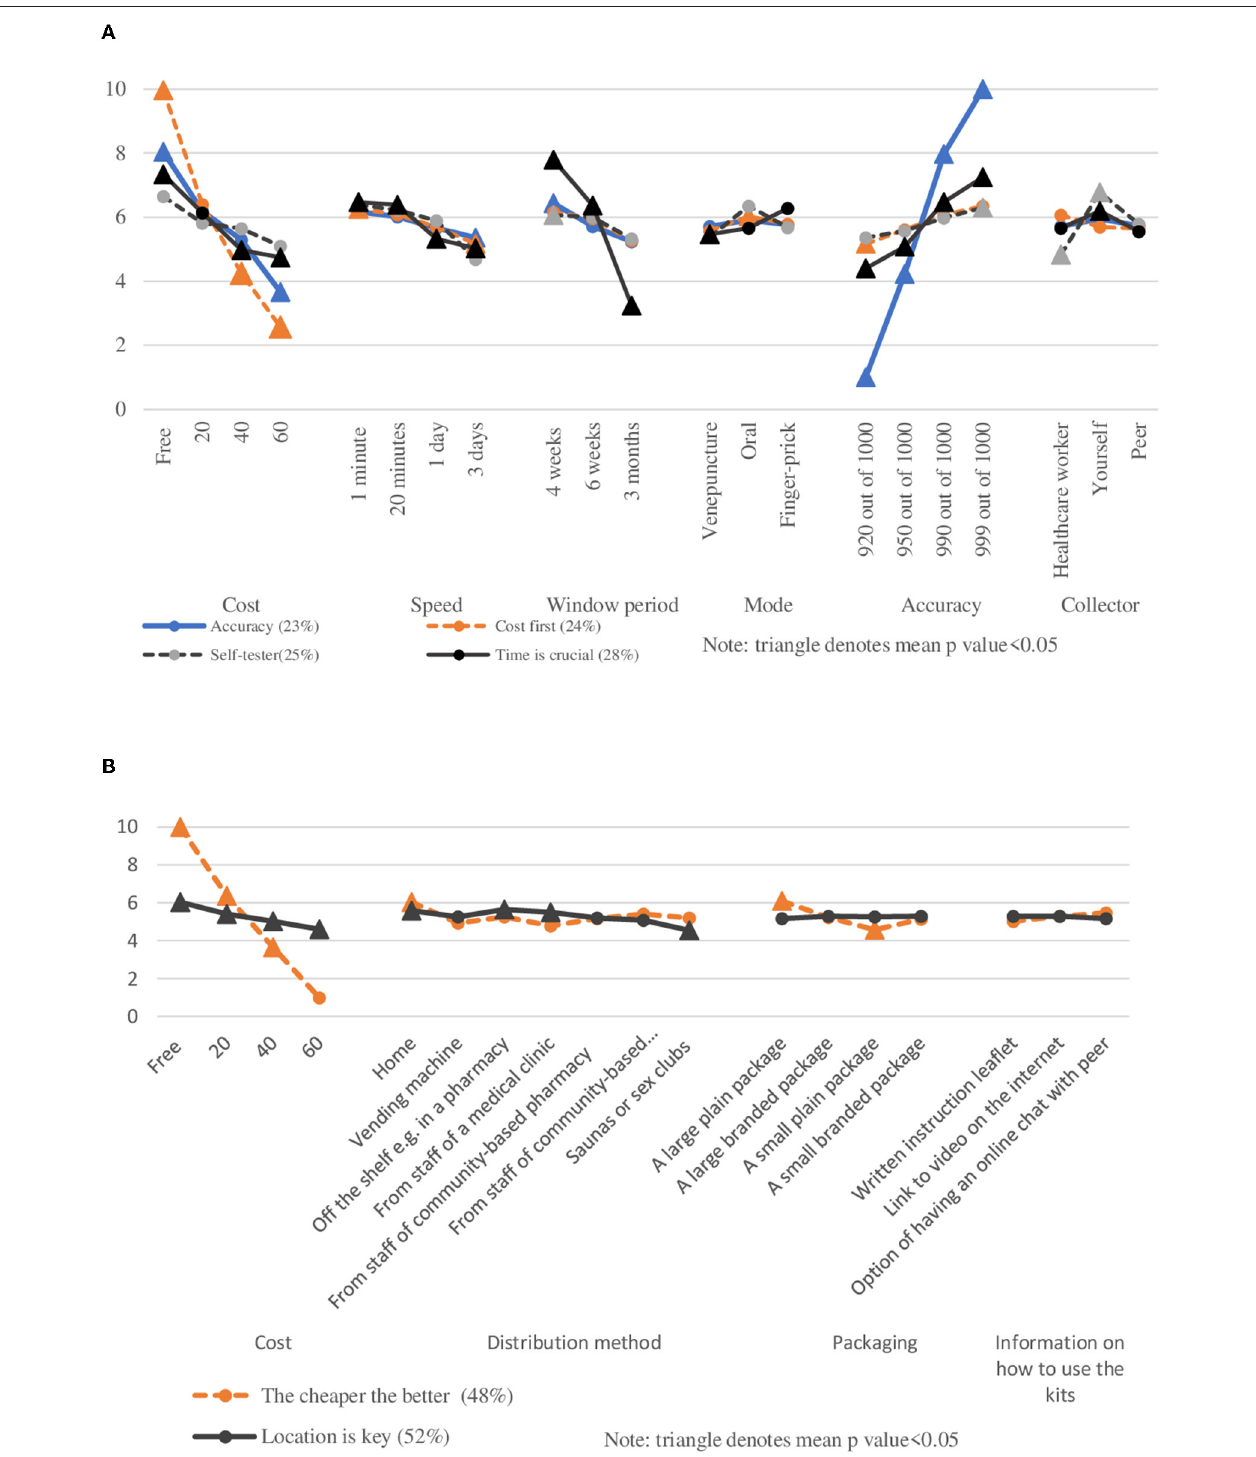
FIGURE 4 | (A) Scaled estimates of HIV testing preferences among non-RHCA country group, by classes. (B) Scaled estimates of HIV self-testing distribution preferences among non-RHCA country group, by classes. Note: Triangle denotes mean p < 0.05